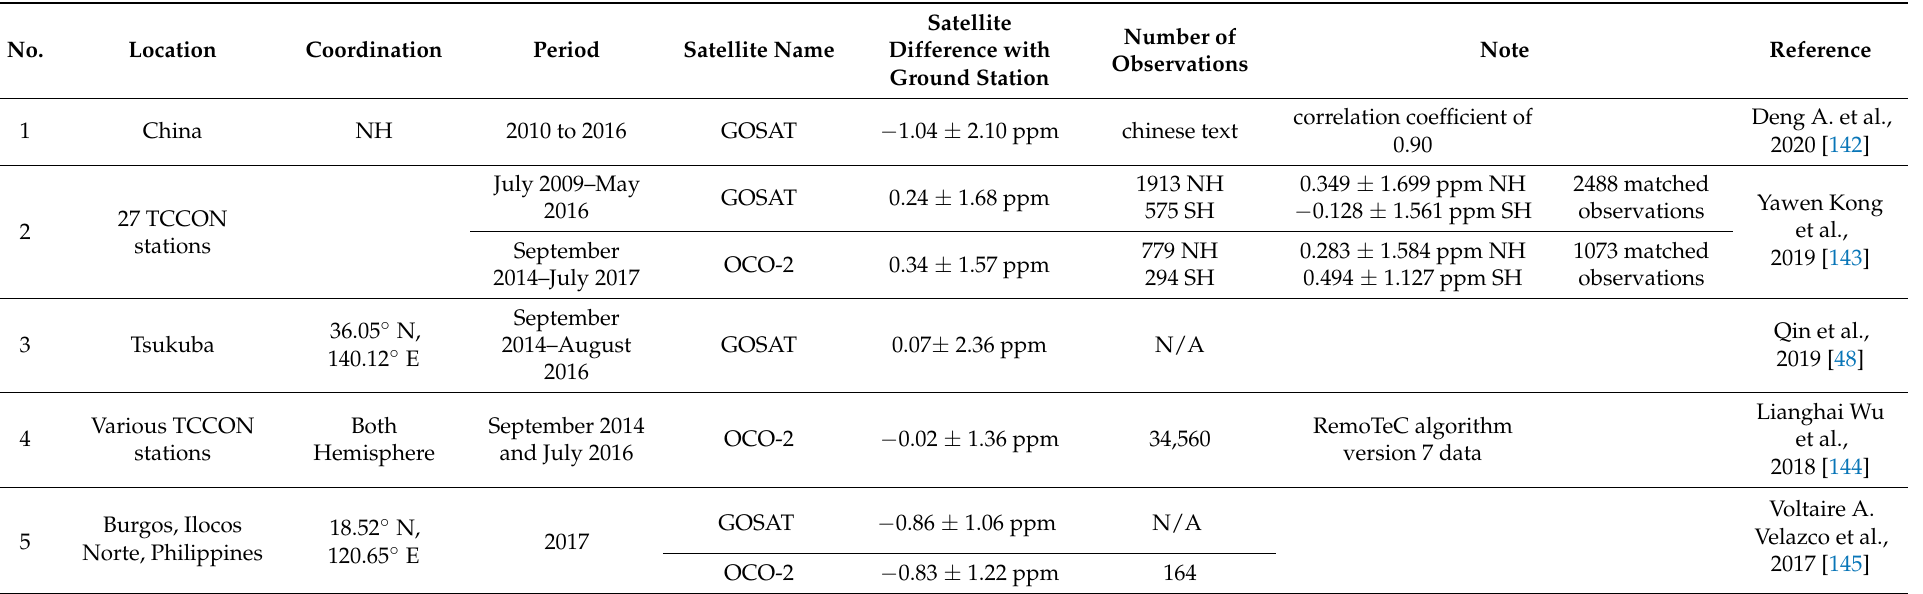
Table A4. Comparison of satellite data and TCCON